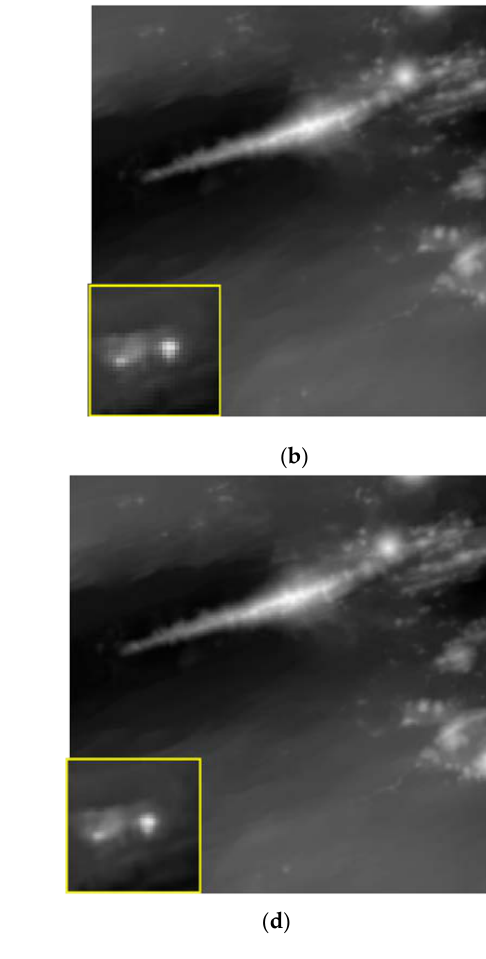
Figure 5. Seabed topography in area 0_2. ( a ) The original image; ( b ) Low-resolution input image; ( c ) Sparse coding super-resolution (ScSR: the proposed method); ( d ) Bicubic interpolation.